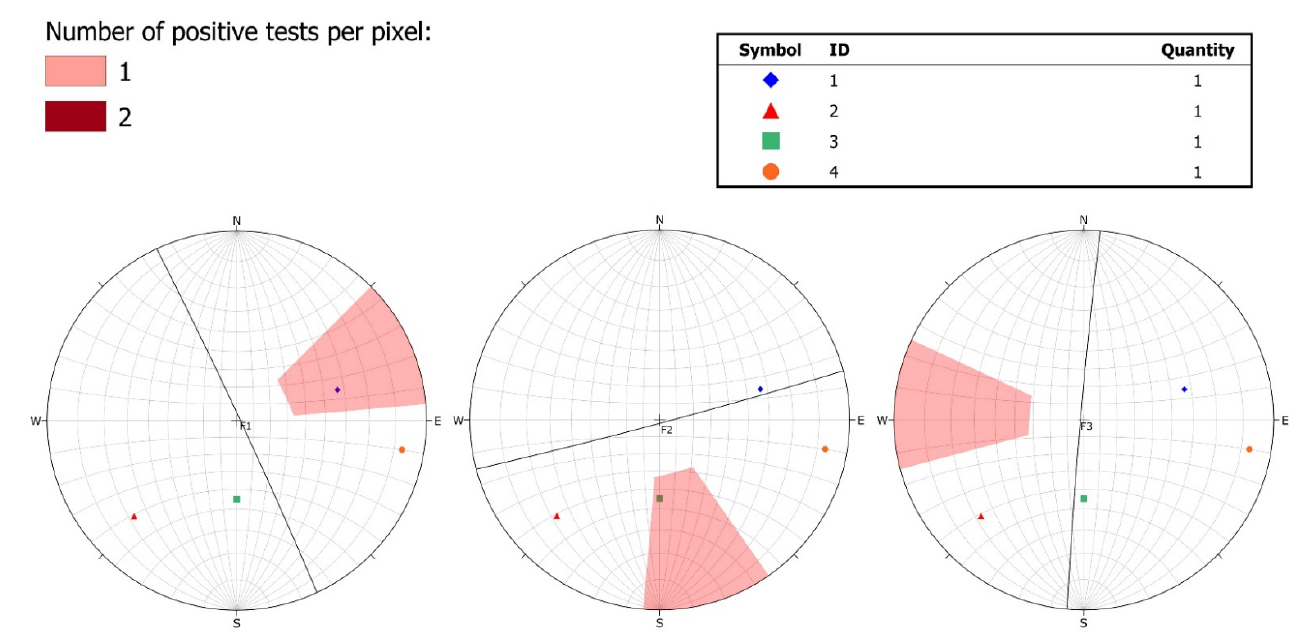
Figure 11. ( above ) Image of the TP sum matrix showing the pixels where the kinematic test for TP is positive: on eastward exposed surfaces, up to two joint sets test positive at a time; ( below ) the three traditional stereoplot kinematic tests for TP on the F1 to F3 slope configurations: only F3 gives no positive result, but it is visible how surfaces oriented towards SW could produce toppling through joint set K2 (047/73); F2 shows that joint set K3 (360/45) is active on southward oriented surfaces, while F1 establishes that on eastward exposed surfaces, both K1 (253/58) and K4 (280/83) joint sets could test positive.